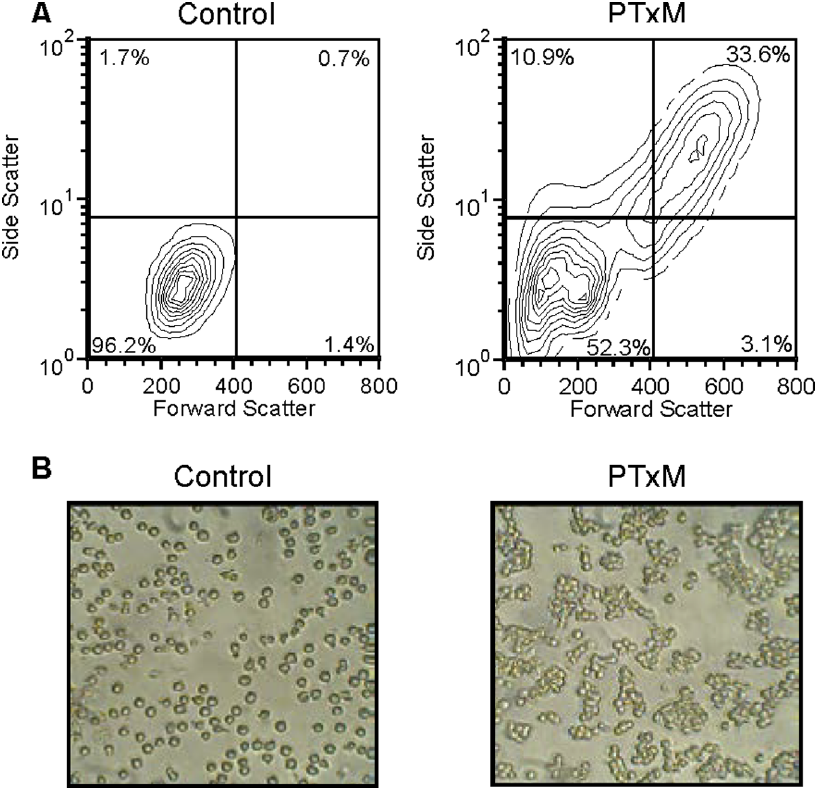
Figure 1. PTxM-mediated aggregation of Jurkat cells. A. Analysis of by flow cytometry showing the forward scatter and side scatter profiles. Control, untreated cells (1 hr at 37 u C); PTxM treated (7.9 nM for 1 hr at 37 u C). B. Microscopic examination of Jurkat cells, control and PTxM treated as described above.